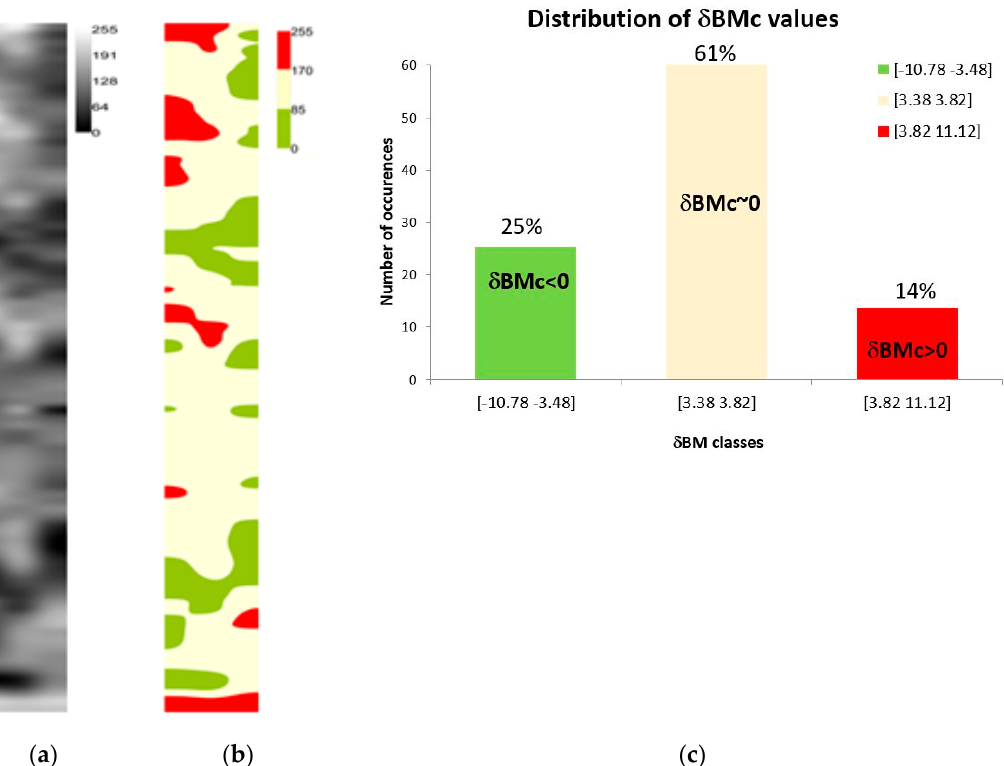
Figure 7. Date 1: ( a ) Wheat biomass (BMc) deduced from the FVCc map; ( b ) δ BMc map; ( c ) Distribution of δ BMc values.